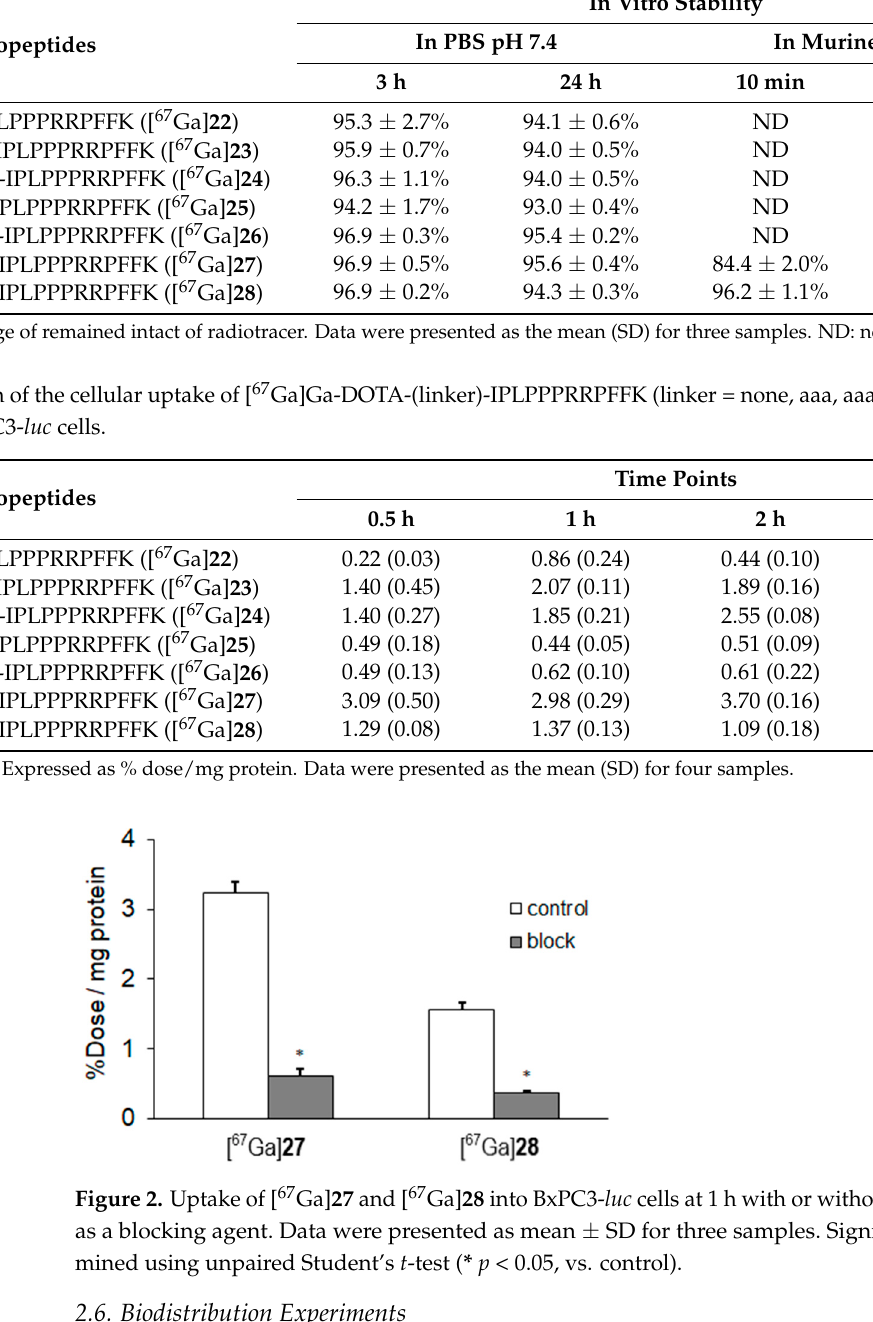
Table 2. In vitro stability of [ 67 Ga]Ga-DOTA-(linker)-IPLPPPRRPFFK in PBS pH 7.4 and murine plasma.